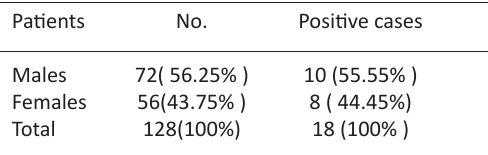
Table 1. Distribution of Brucella patients according to gender and their percentage with RBT.